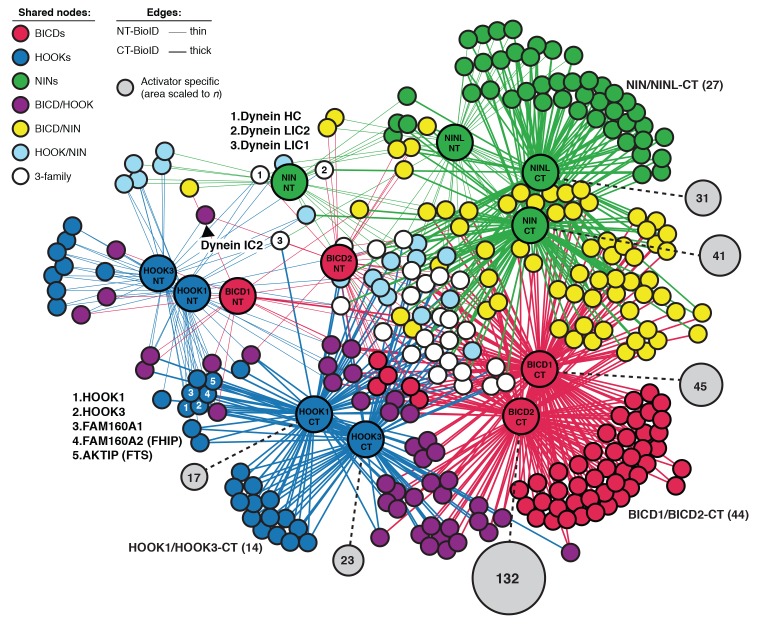
An interaction map of the N- and C-terminal activator datasets combined.Enriched and significant hits from the combined N- and C-terminal datasets of six activators were used to construct a single protein-protein interaction network. Hits (small spheres) specific to an activator family (color-coded according to their respective activators), and hits shared between activator families (HOOK/BICD, purple; BICD/NIN, yellow; NIN/HOOK, cyan) are shown. White spheres (‘3-family’) represent hits enriched in at least one activator (NT or CT) from each family. Lines connecting spheres (edges) are color coded according to activator family and termini (NT = thin, CT = thick). The regions encompassing activator family CT-specific overlap are indicated with their respective n. The number of unique hits for each dataset is represented as a gray circle that is scaled according to the number of hits and the number of hits is shown. For this figure enrichment is ≥3 fold, significance is p<0.05, Student’s two-tailed t-test; and average spectral counts are ≥2. The location of dynein and dynactin subunits and select hits discussed in the text are indicated.